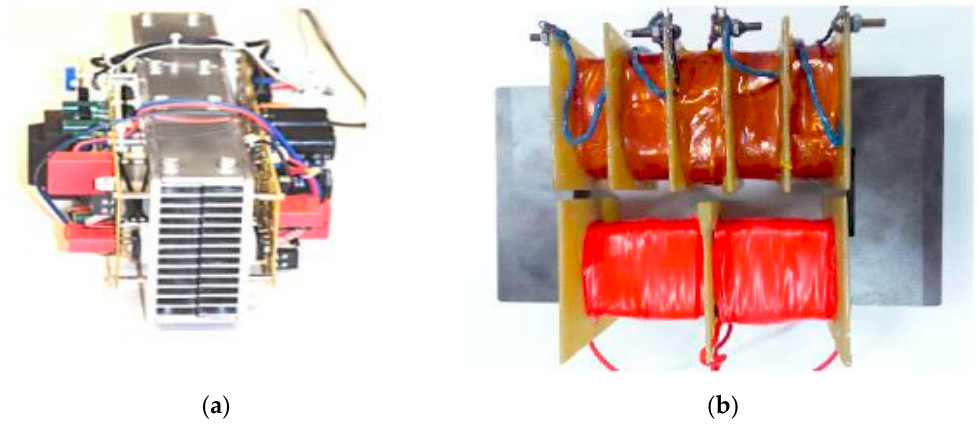
Figure 1. Simplified schematic diagram of the described processes of energy conversion in switched-mode push–pull power supply for micro gliding arc discharge reactors ( µ GAD).